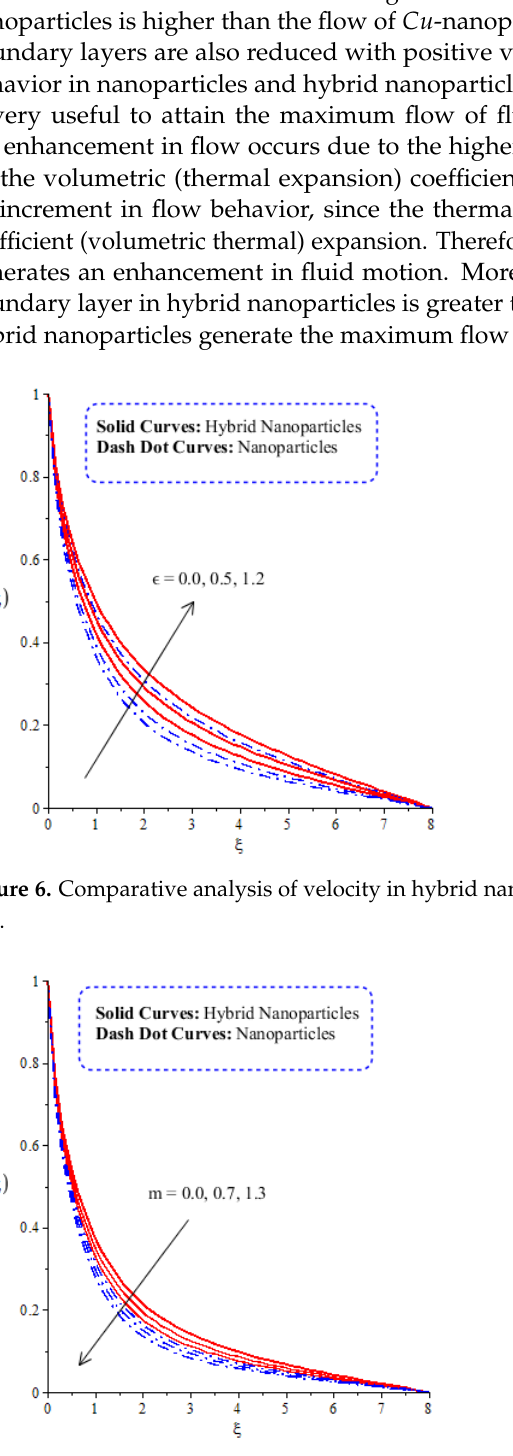
Figure 7. Comparative analysis of velocity in hybrid nanoparticles and nanoparticles versus change in 𝑚 .